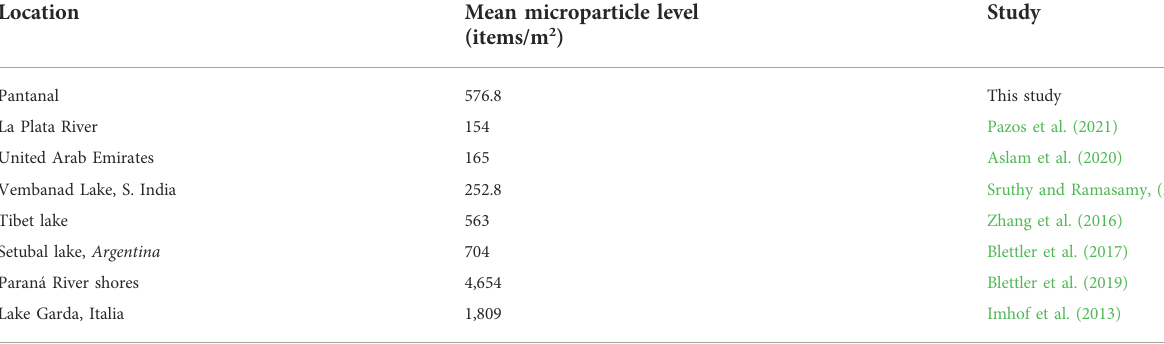
TABLE 2 Mean levels of microparticles on the shore sediments of water bodies around the